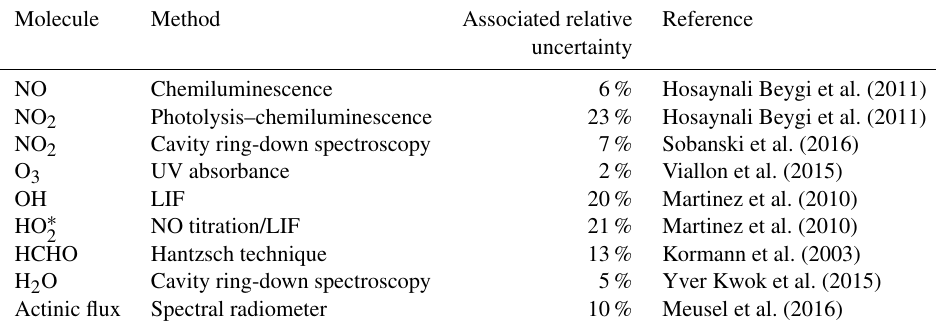
Table 1. List of observations and gas-phase measurements during AQABA. The relative uncertainty associated with each data set is also given. Note that the relative uncertainty for OH and HO ∗ is estimated as the 1 σ accuracy (and the 7% interference of RO 2 in the case of 2 HO ∗ data). In addition, a reference is given regarding the practical use of each 2